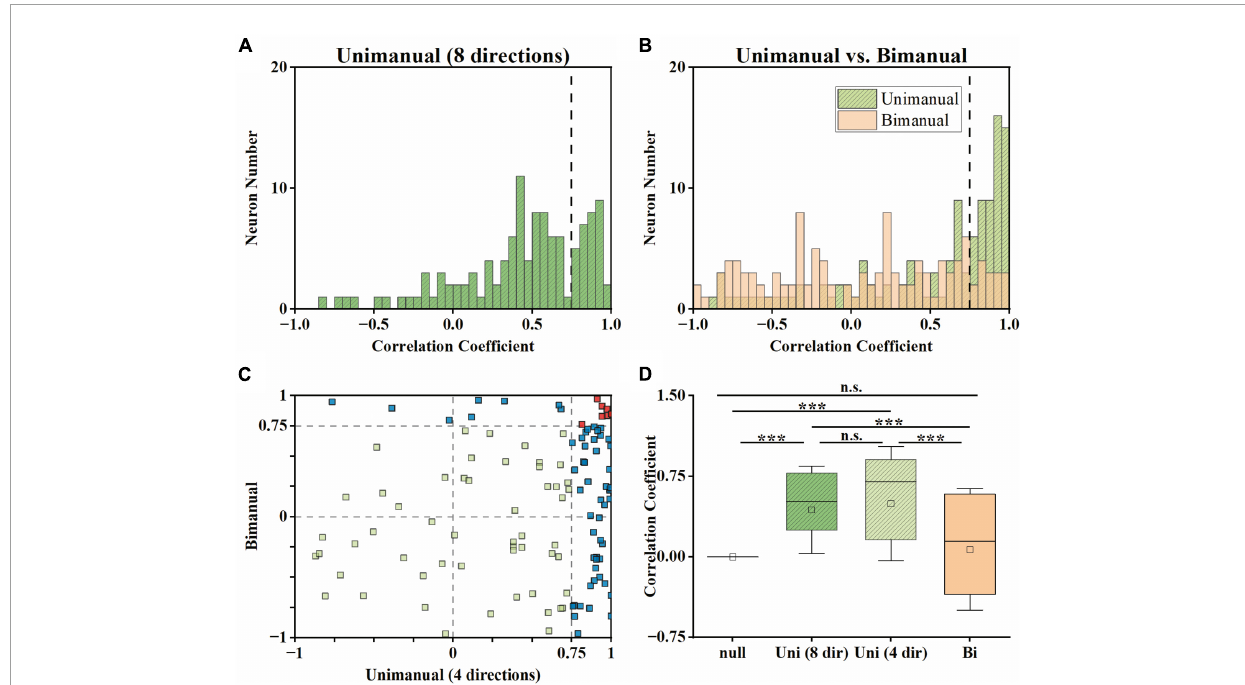
FIGURE6 Neural activity for ipsilateral and contralateral arm movements was decorrelated across the unimanual and bimanual tasks. (A) For each neuron, we computed the cc between the tuning curves for 8 movement directions of each arm in the unimanual task. (B) Same as in panel (A) , but for the 4-direction data in the unimanual (green) and bimanual (orange) tasks. (C) Scatter plot of the cc in panel (B) for each neuron. 47.0% (55/117) of the neurons had a strong positive correlation ( cc > 0.75) between the tuning curves for the two arms in the unimanual task while it declined to 12.8% (15/117) in the bimanual task. (D) Boxplots illustrated the median, the 25th, and 75th percentiles, and outliers outside the extremes (black diamonds) for the cc in panels (A,B) . The squares represent the mean. Error bars indicate the SD. Overall, these results revealed that the strong correlation between the ipsilateral- and contralateral-related activity disappeared in the unimanual versus bimanual tasks. *** p < 0.001, t -test.